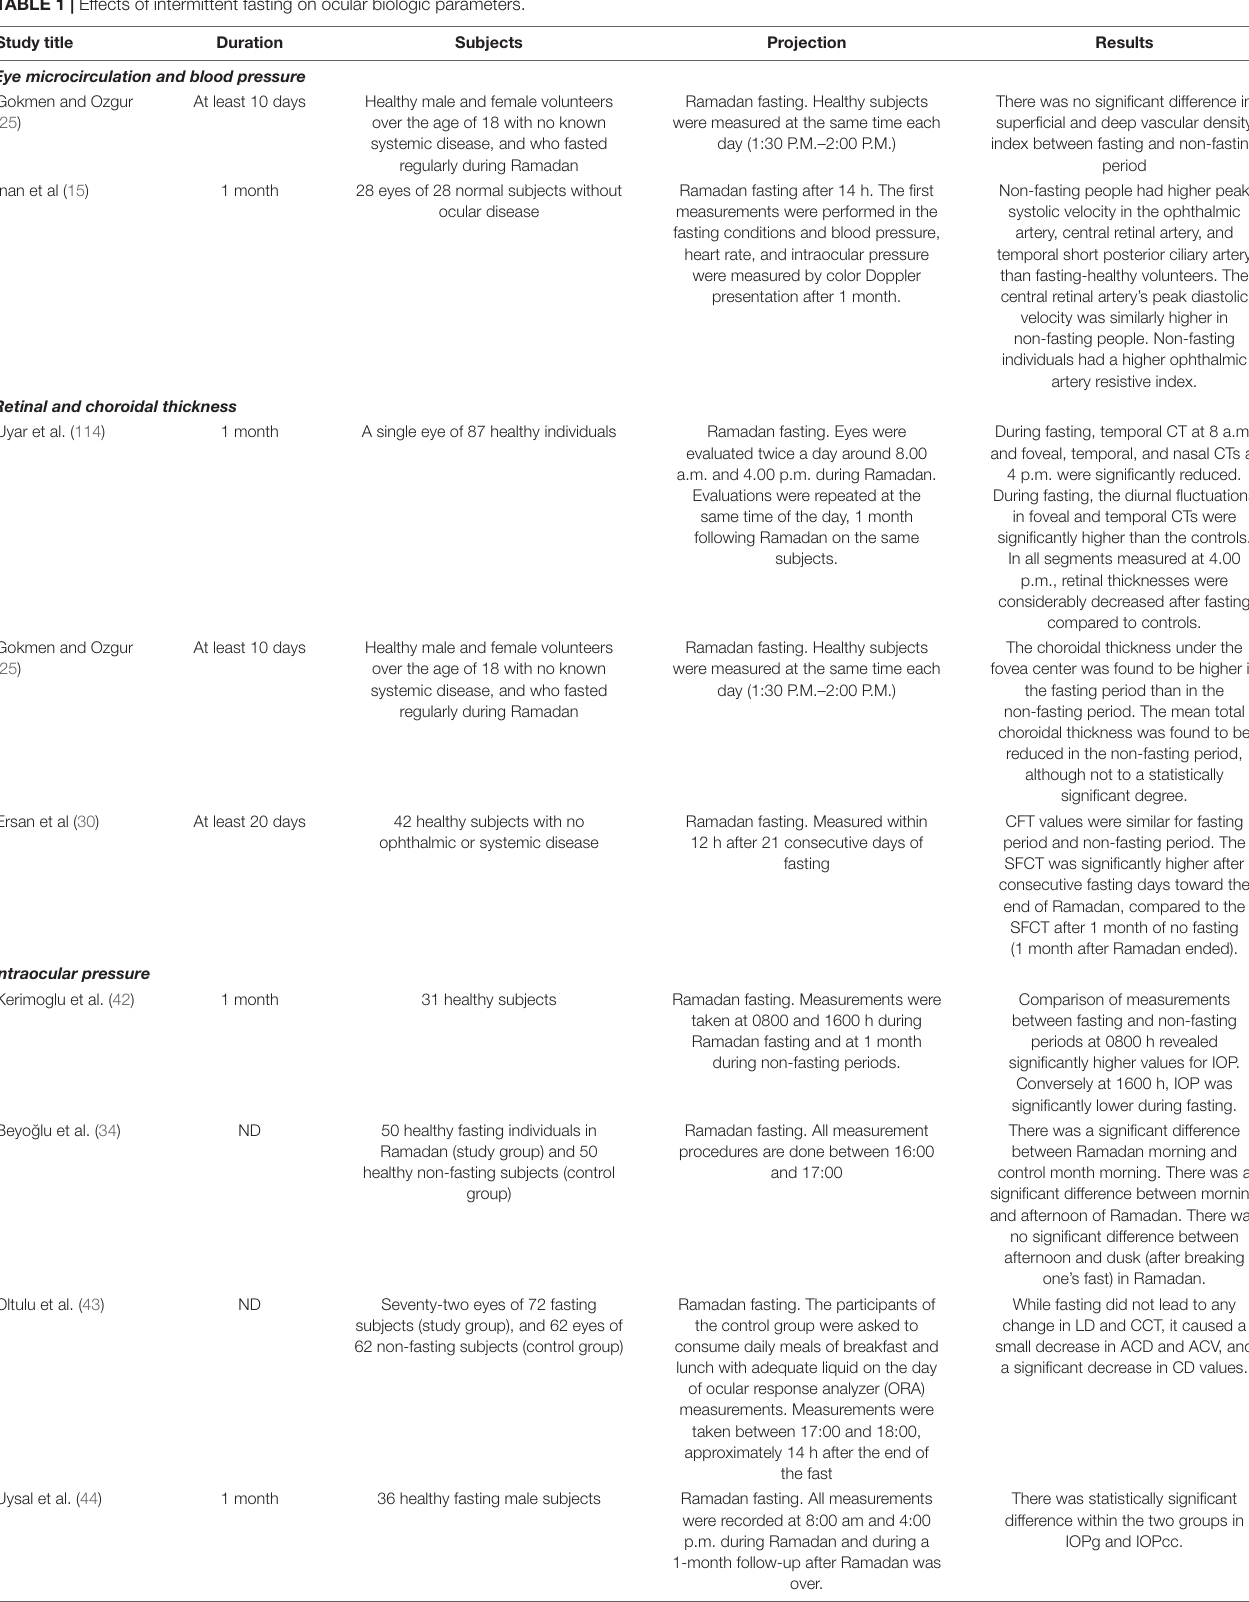
TABLE 1 | Effects of intermittent fasting on ocular biologic